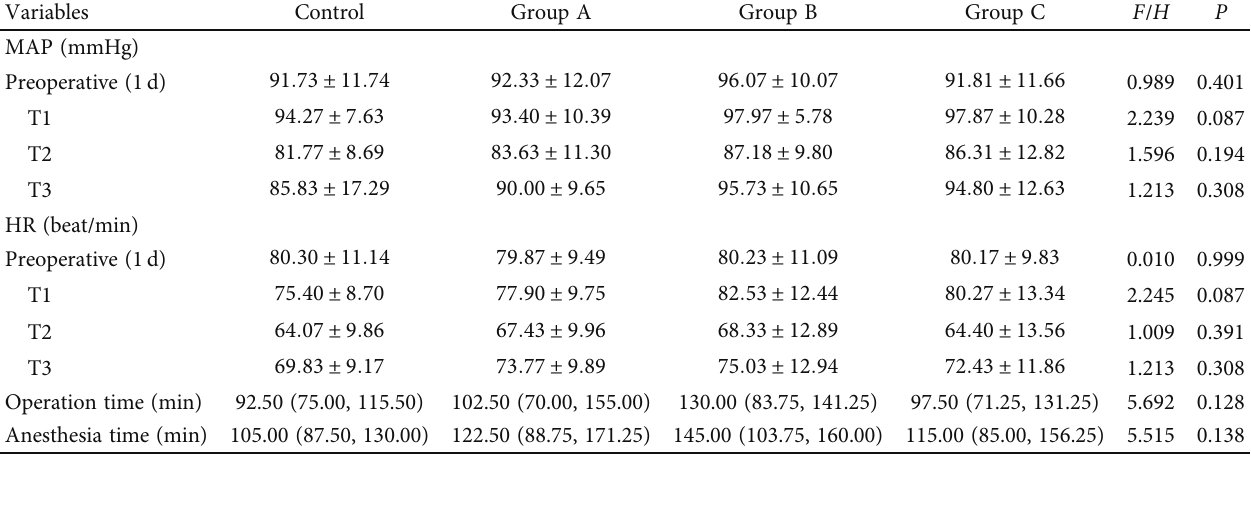
Table 2: Comparison of changes in vital signs ( n = 30 ).